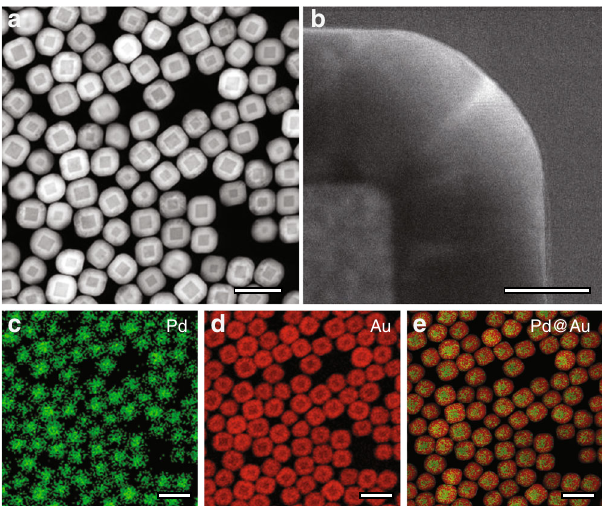
Fig. 1 TEM characterization of Pd@Au core – shell nanocubes. a Low- magni fi cation and b high-magni fi cation STEM-HAADF images of Pd@Au nanocubes (44-nm core and 35-nm shell). c – e STEM-EDX results of Pd@Au nanocubes with elemental maps for Pd c , Au d and their overlay e . Scale bars: 200 nm a , c – e and 20 nm b .